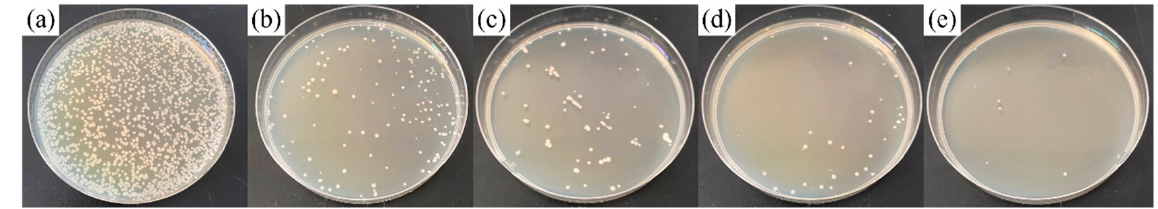
Figure 10. Typical photos of the re-cultivated S. aureus colonies on agar for different samples: ( a ) Substrate; ( b ) Ag-1 × 10 16